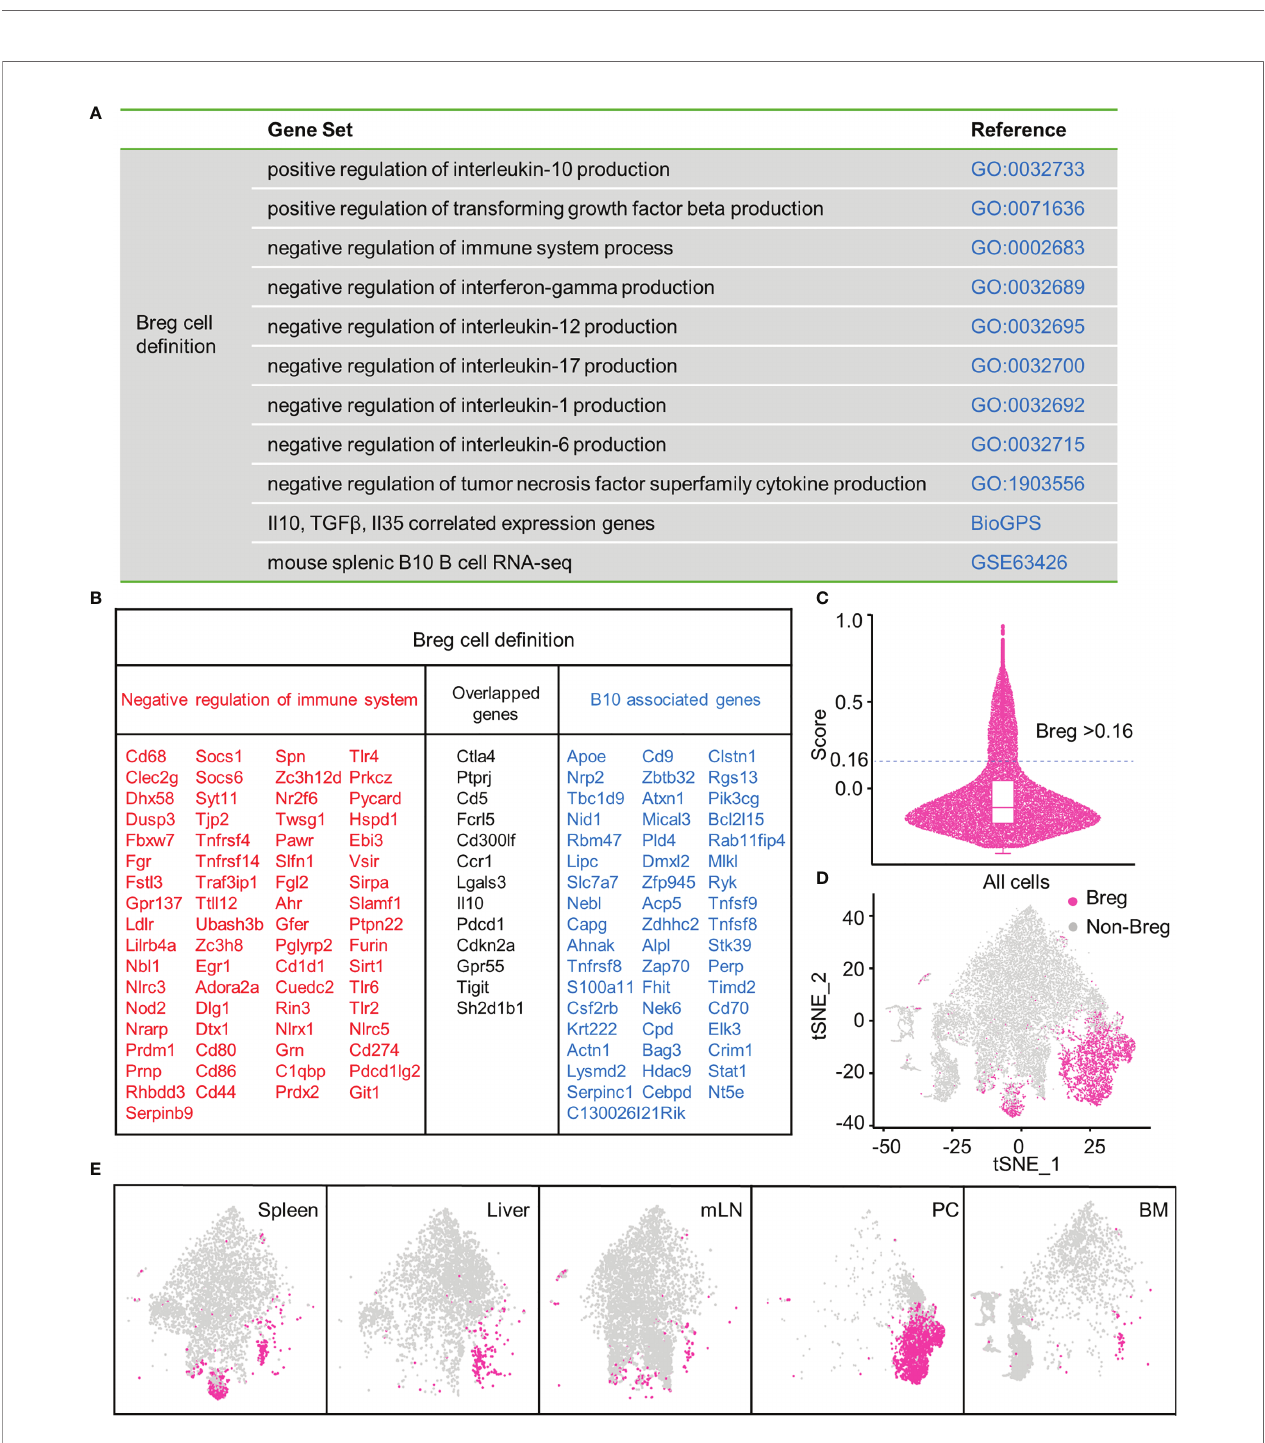
FIGURE 1 | Breg cells analysis by high-throughput scRNA-seq in different organs. (A) Gene sets from GO, BioGPS, and GEO databases. (B) List of selected genes for identifying Breg cells. (C) Evaluation of the Breg cell module score. (D) t-SNE plot of Breg cell distribution in total B cells from all organs. (E) t-SNE plot of Breg cell distribution in spleen, liver, mLN, PC, and